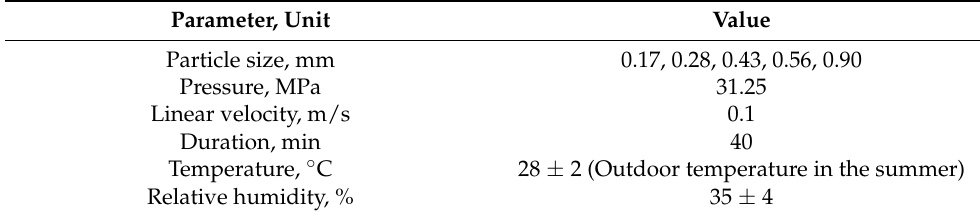
Table 1. Experimental